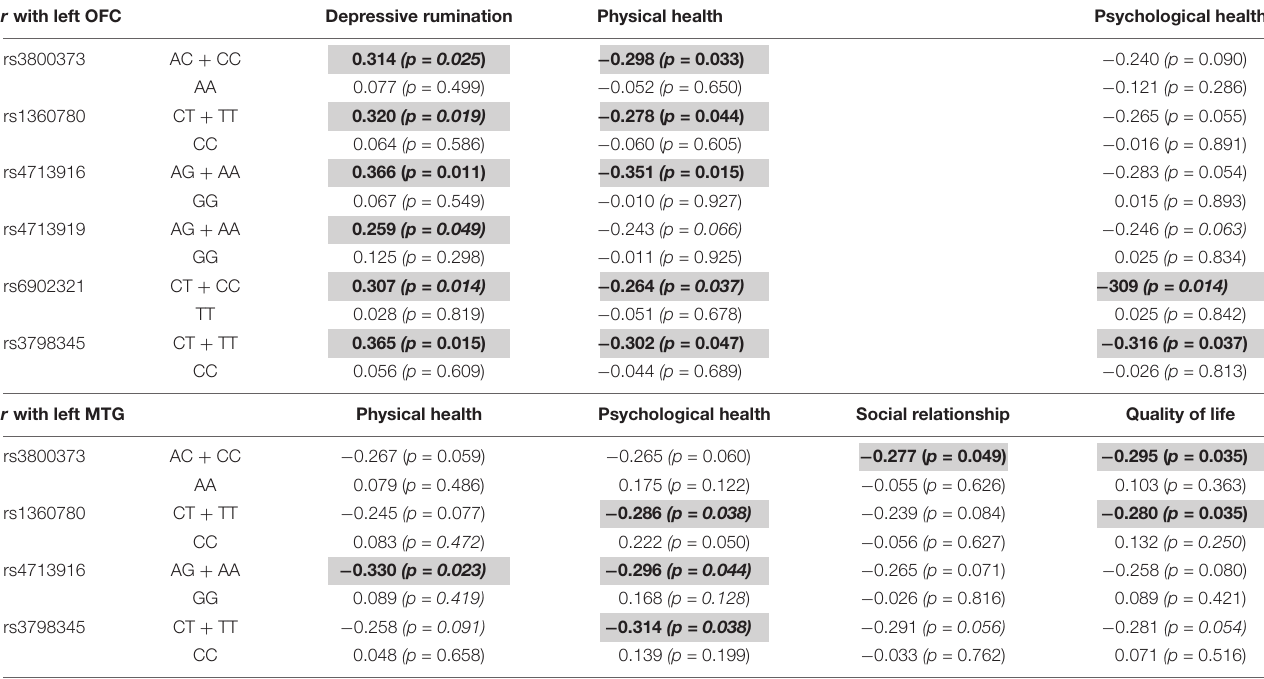
TABLE 3 | Brain regions affected by the interaction between FKBP5 variants and the childhood trauma and the related psychological variables among genotypes r with left OFC Depressive rumination Physical health Psychological